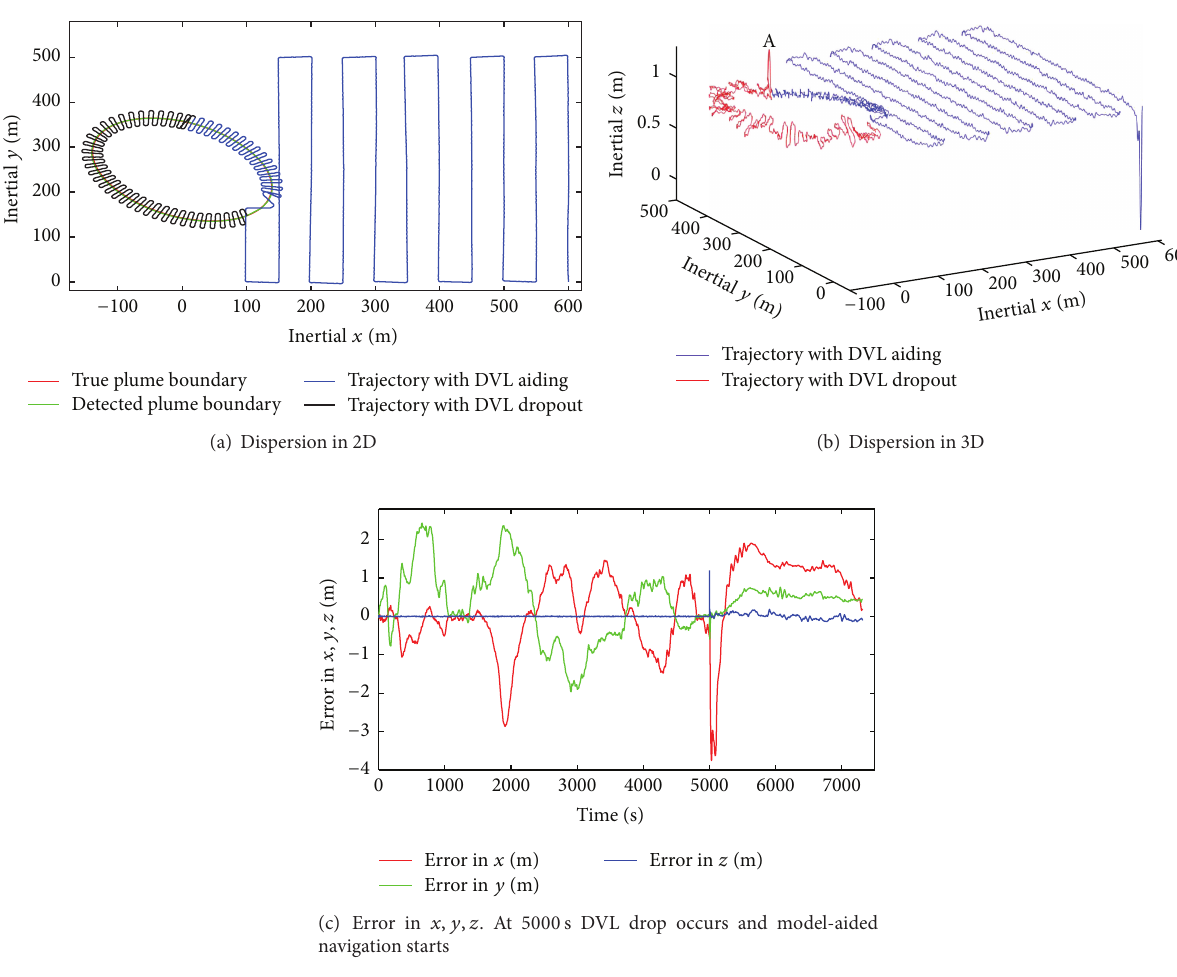
Figure 12: Plume with an ellipse-shaped